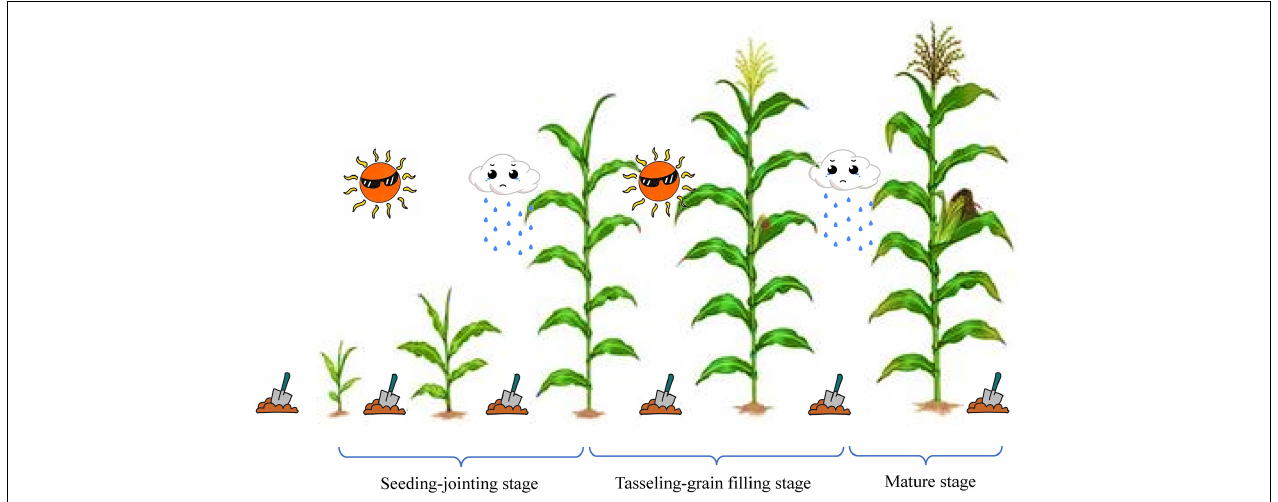
FIGURE 1 | Sampling time points during experiments. DFAA, drought-flood abrupt alternation; BV, baseline value, sampling before the DFAA experiments; BPre, before precipitation, i.e., before drought, sampling 1 day before every rainfall experiment; APre, after precipitation, i.e., after drought, sampling 3 day after every rainfall experiment; M, mature stage, sampling at the mature